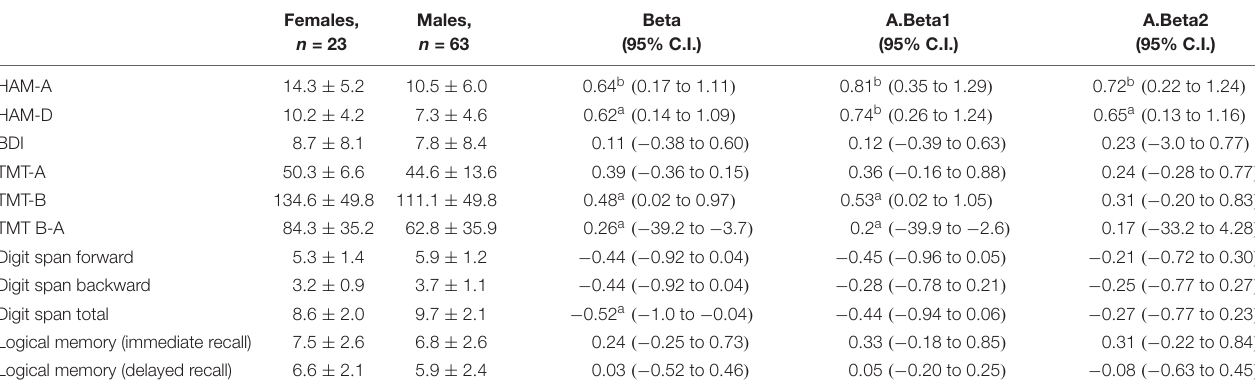
TABLE 2 | Gender effect in psychological and neuropsychological